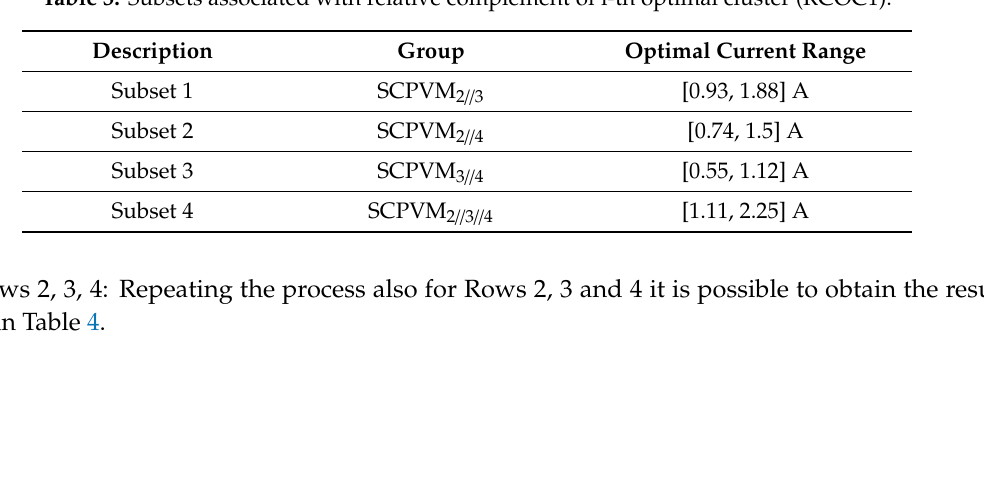
Table 3. Subsets associated with relative complement of i-th optimal cluster (RCOC1).